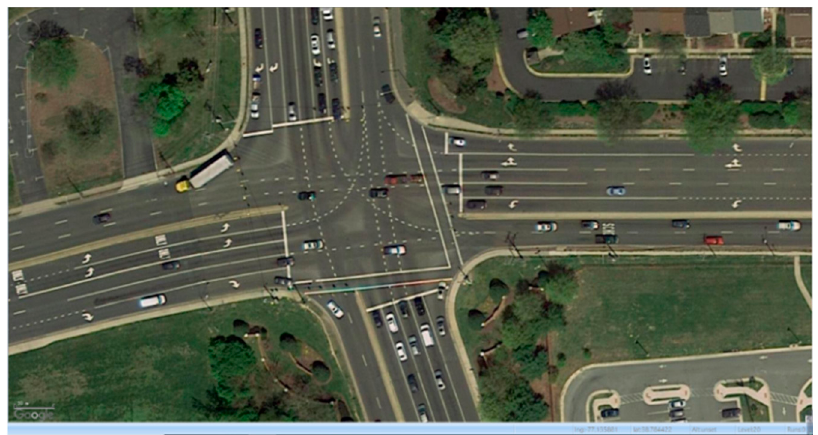
Figure 10. Remote sensing image of an intersection in Washington, America.